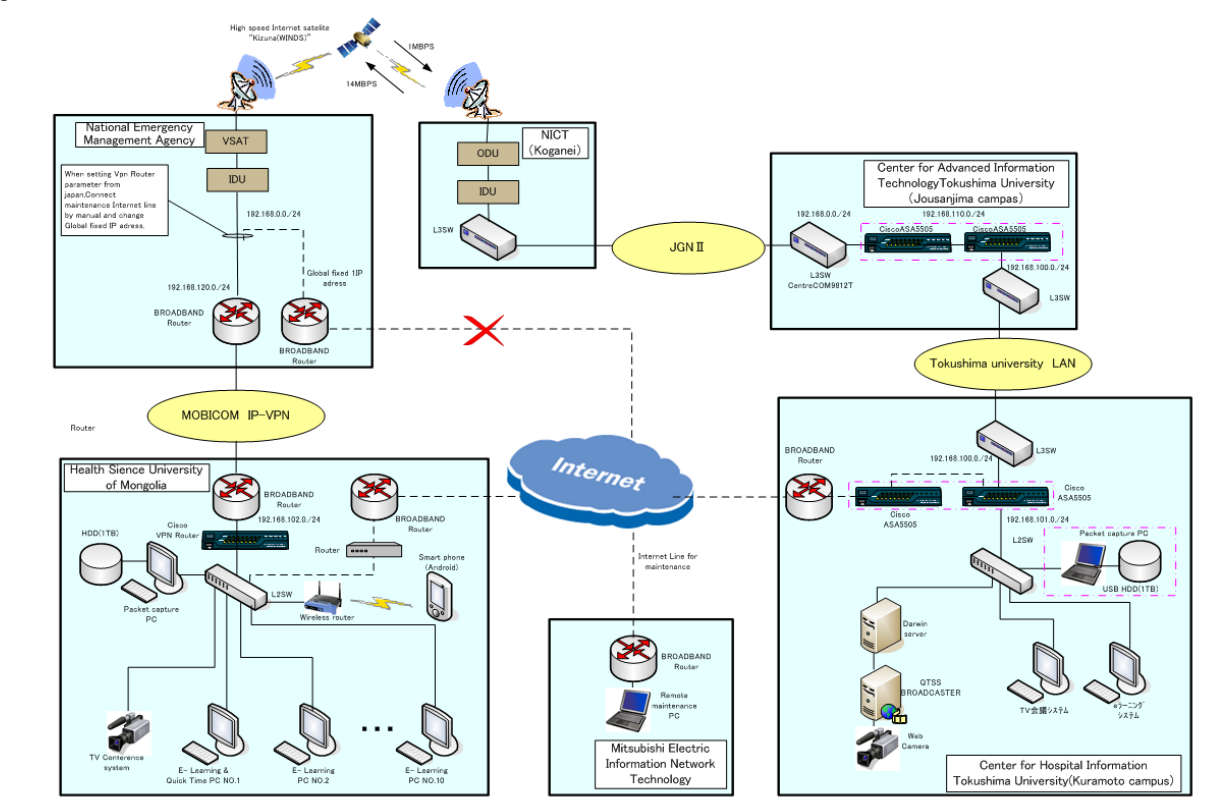
Figure 3. Network